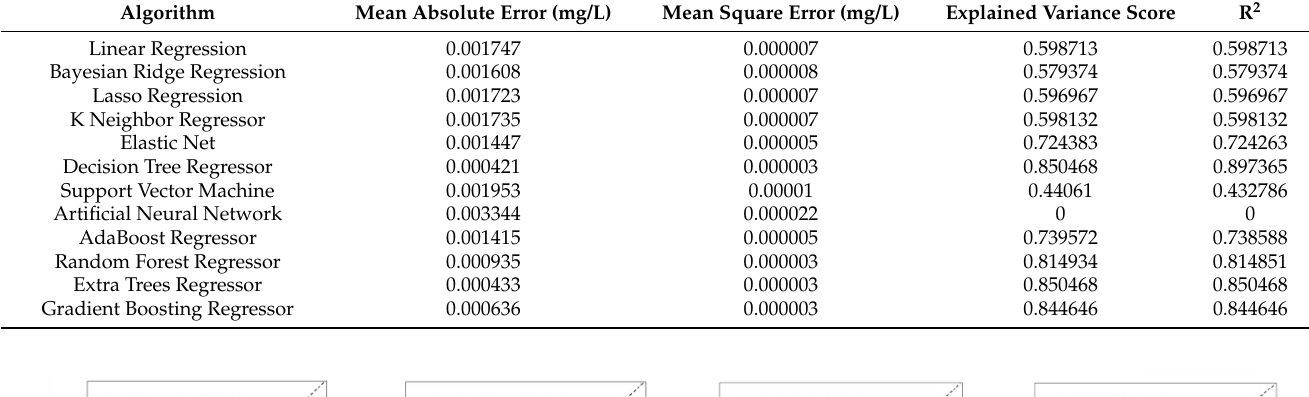
Table 2. The assessment parameters of model performance for the TP concentration.